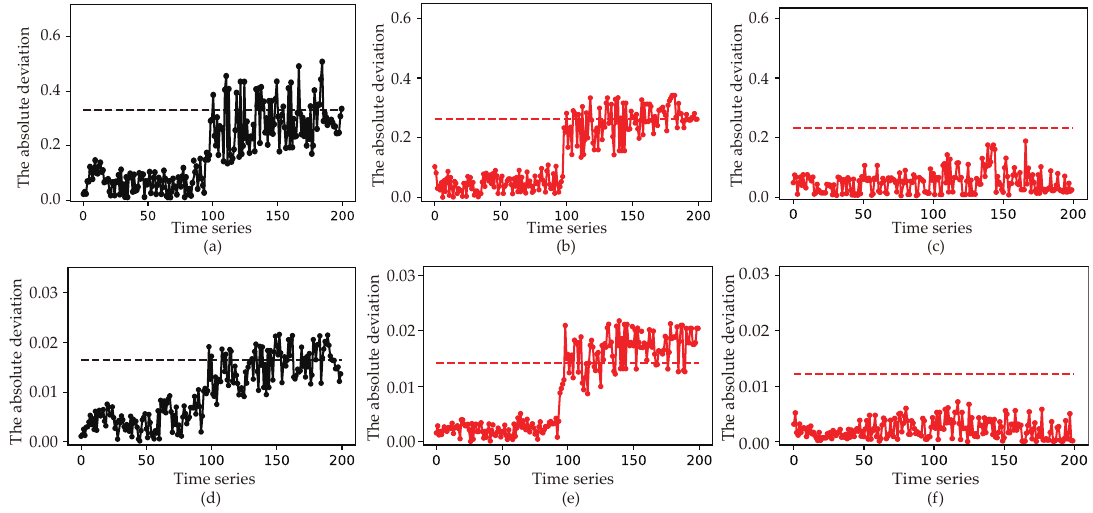
Figure 6. The absolute deviation of T suc and P suc with different virtual sensors. ( a ) The absolute deviation between the physical sensor T suc and the only virtual sensor. ( b ) The absolute deviation between T suc and the first of the two virtual sensor. ( c ) The absolute deviation between T suc and the second of the two virtual sensor after grouping. ( d ) The absolute deviation between the physical sensor P suc and the only virtual sensor. ( e ) The absolute deviation between P suc and the first of the two virtual sensor. ( f ) The absolute deviation between P suc and the second of the two virtual